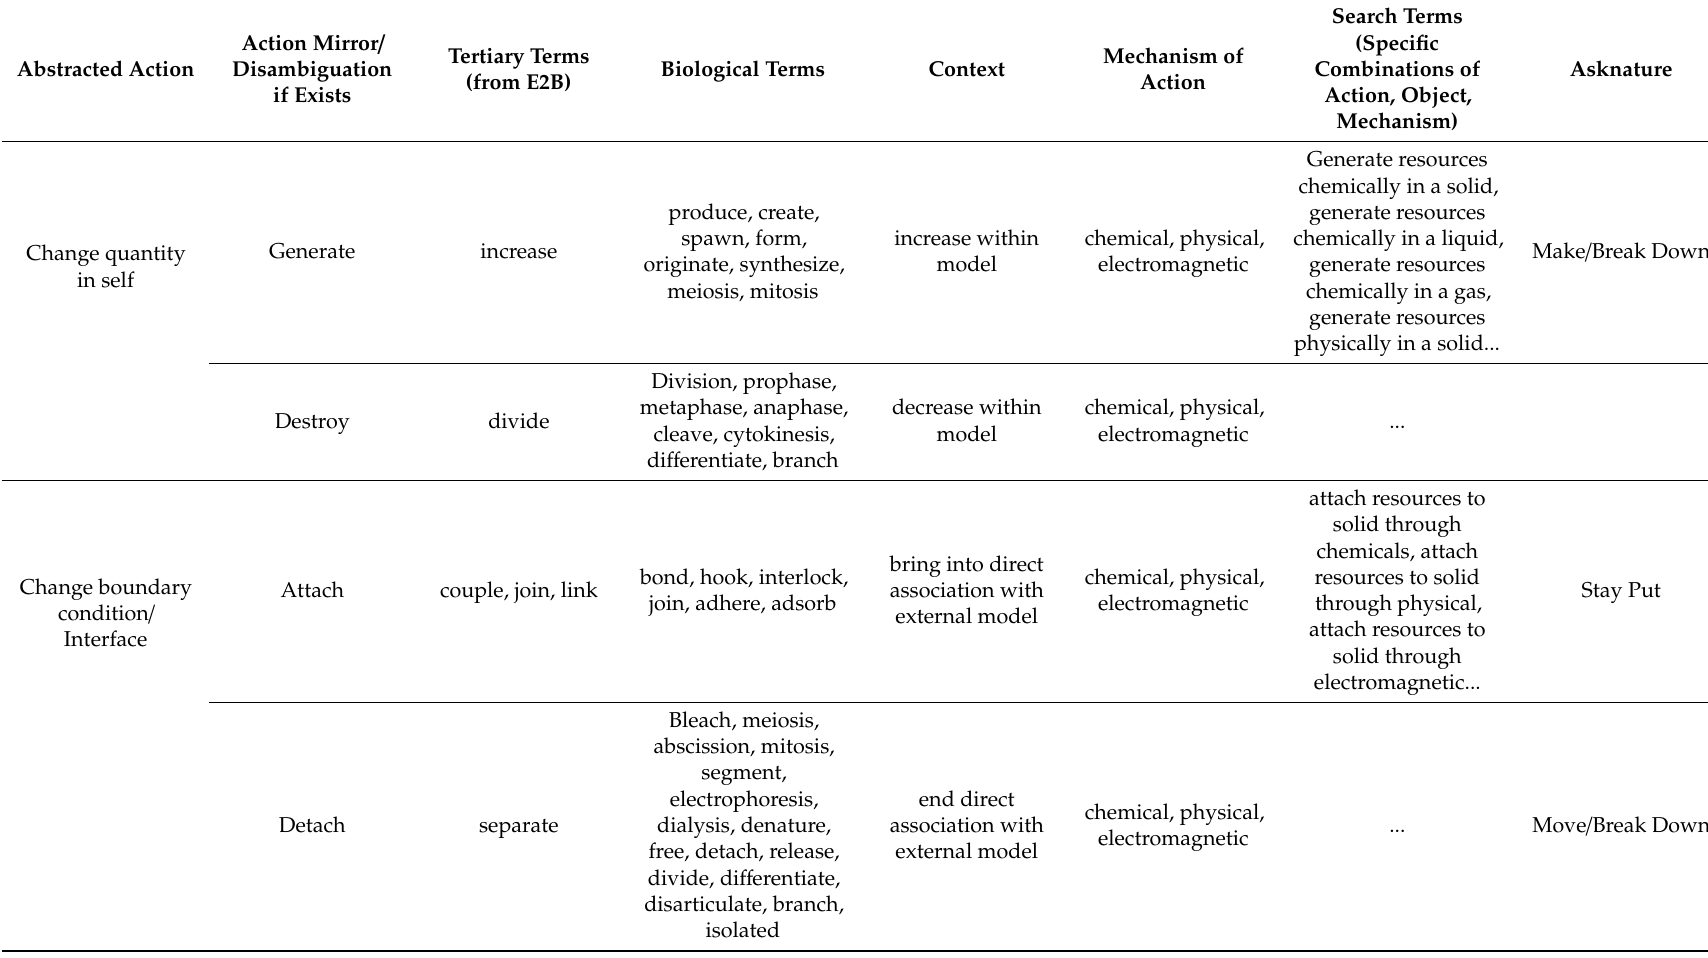
Table 4. Derived taxonomy for PeTaL. Column 1 shows the abstracted action from the specific action in column 2. For brevity, the table is not populated